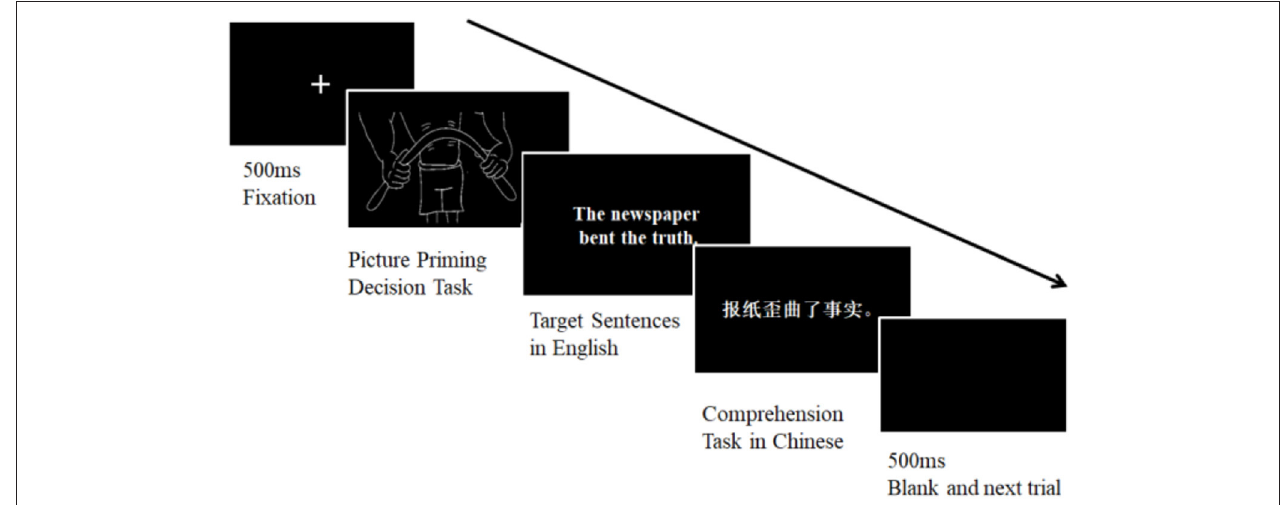
FIGURE 1 | Procedure in the priming condition.